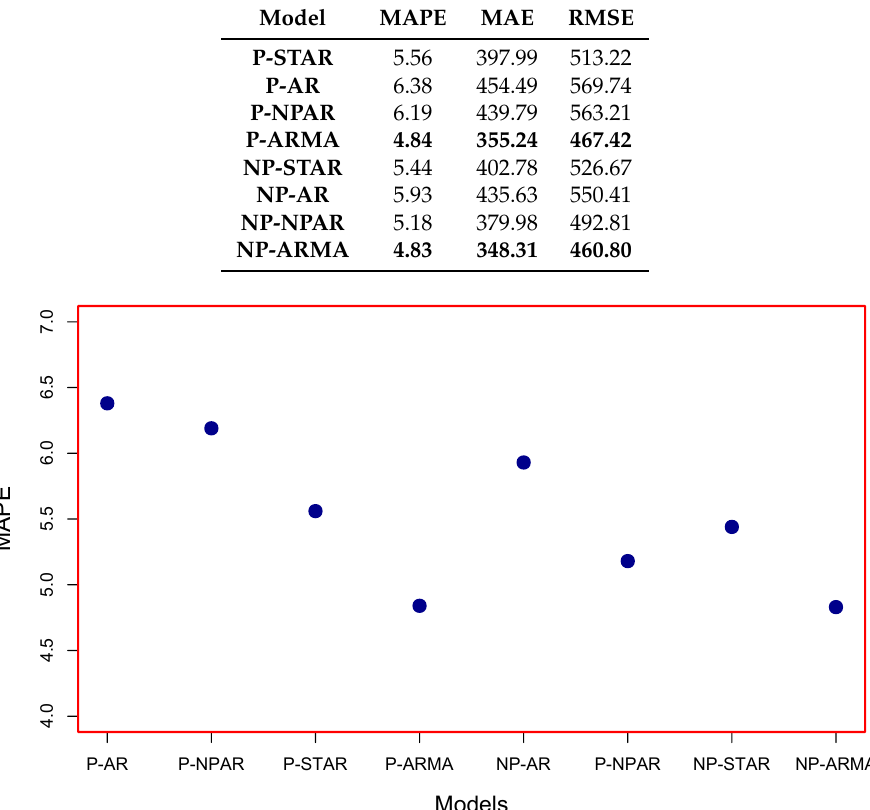
Table 2. Model accuracy statistics for one month ahead out-of-sample forecast.